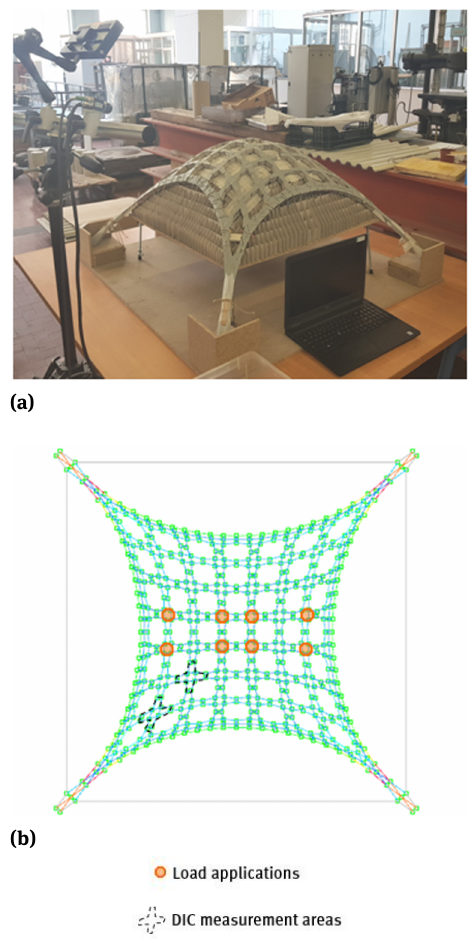
Figure 12: DIC application is shown together with the experimental set-up (a). The geometry of the vault prototype is reported together with the points where the load applications were applied (b)